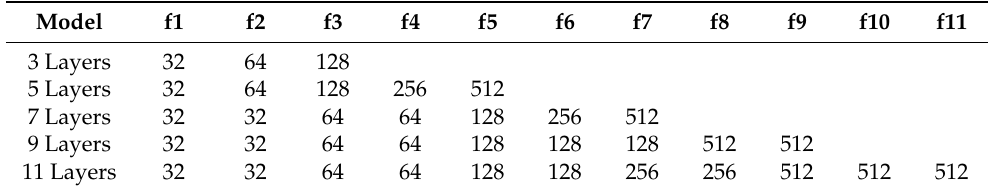
Table 2. Proposed CNN model with various number of convolution layers and filters (f).